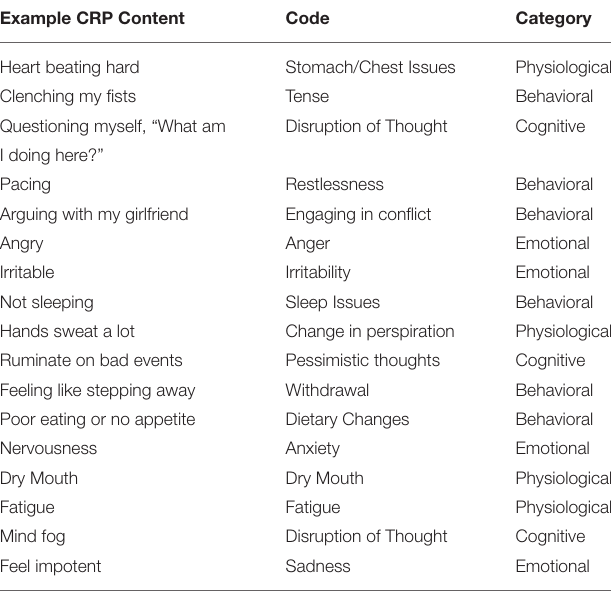
TABLE 1 | Content, code, and categories of warning signs from participant crisis response